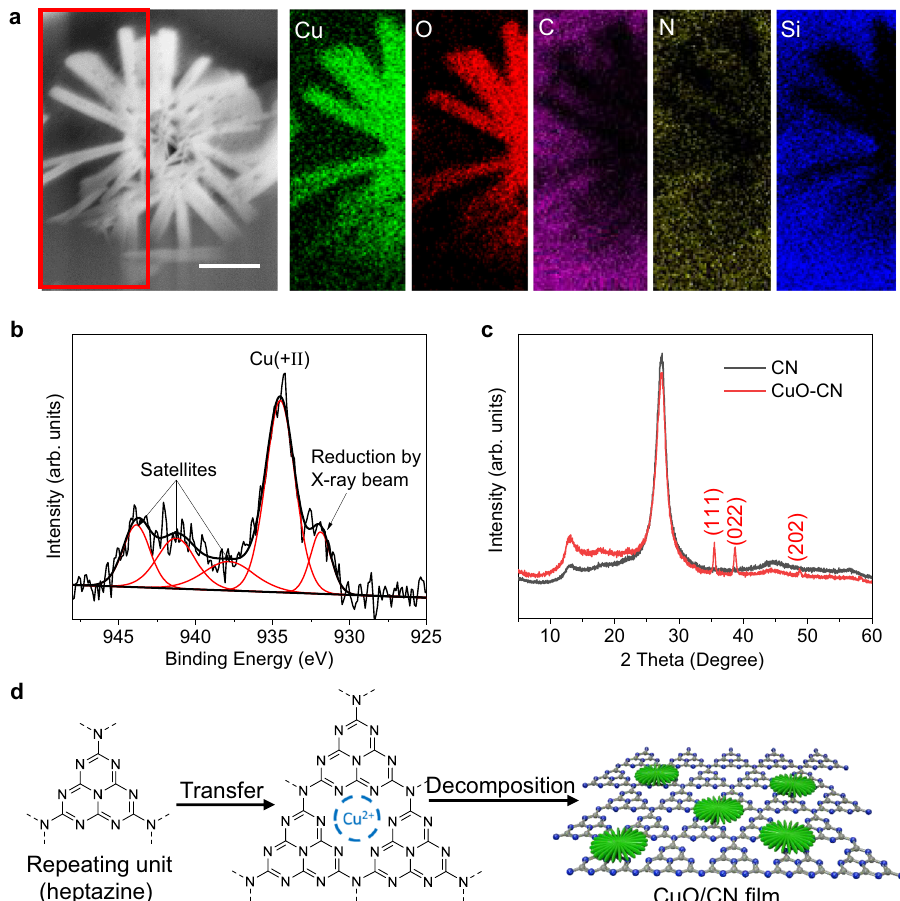
Fig. 2 Characterization of the CuO/carbon nitride (CN) composite material generated by LTRAS. a SEM image and EDX elemental maps of the transferred composite material (scale bar 2 µ m). b High-resolution XPS binding energy spectrum of Cu 2 p . c XRD spectrum of CN and CuO/CN composite fi lms. d Schematic illustration of the synthetic route during the transfer